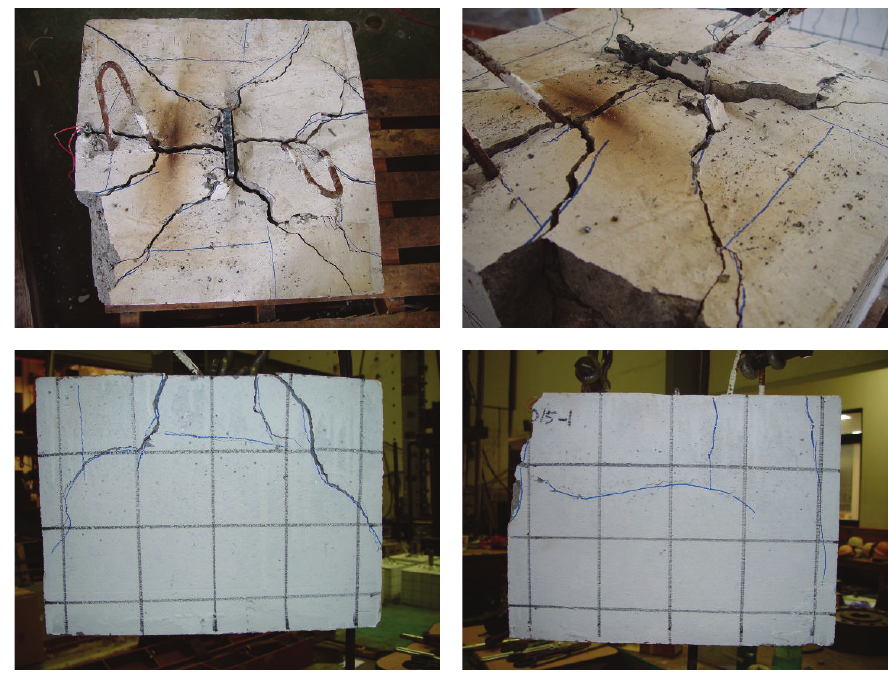
Figure 9: Failure mode of specimen PO-5015-R (Type III).